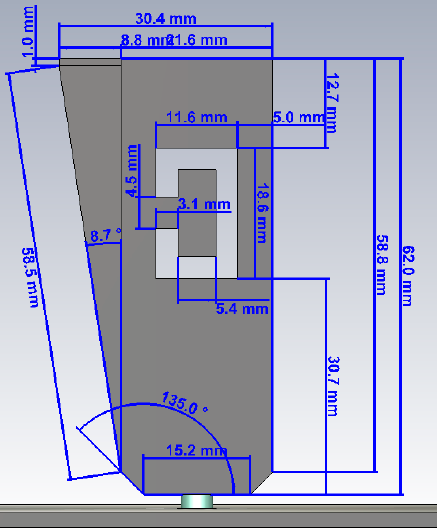
Figure 5. Final dimensions of the blade antenna in dual frequency configuration (XZ side